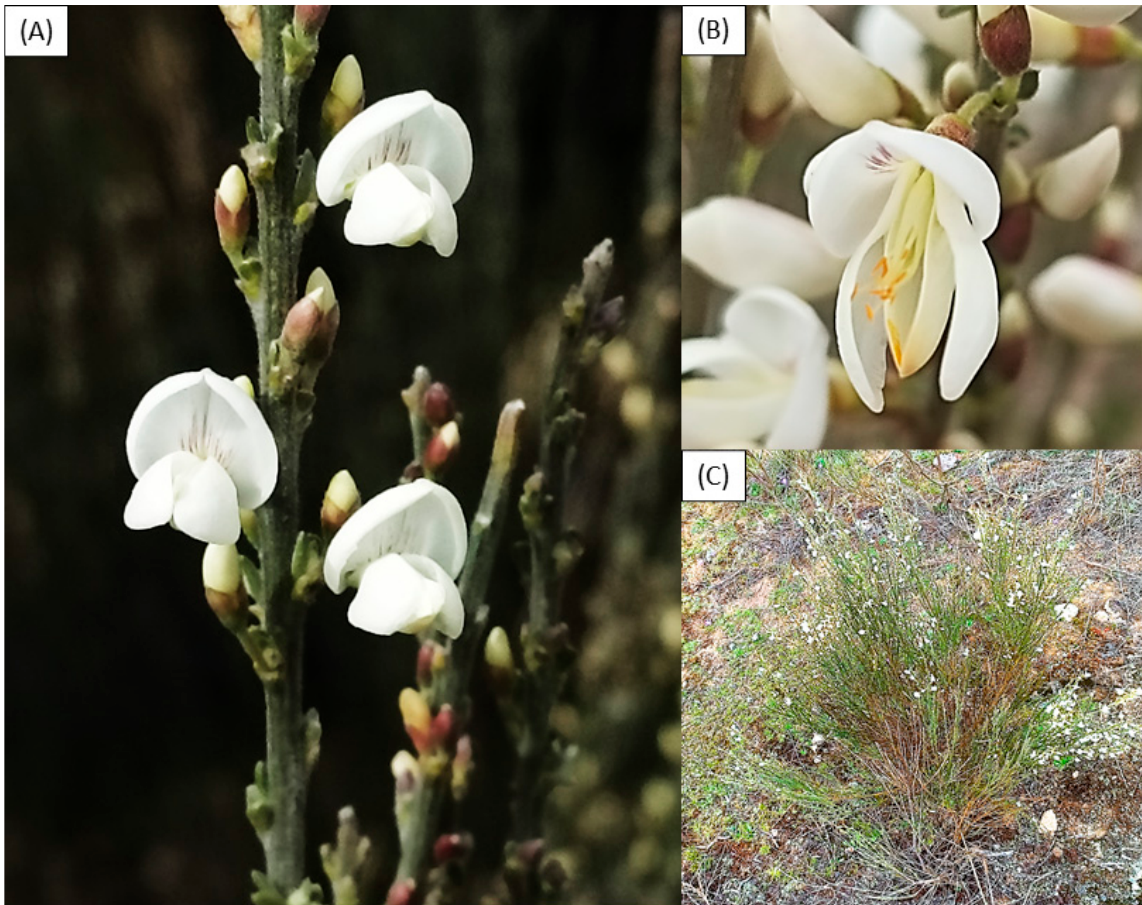
Figure 1. Some examples of C. multiflorus in the Beira Interior region (Portugal); ( A ) branches and flowers of the shrub; ( B ) its characteristic flower; ( C ) a complete